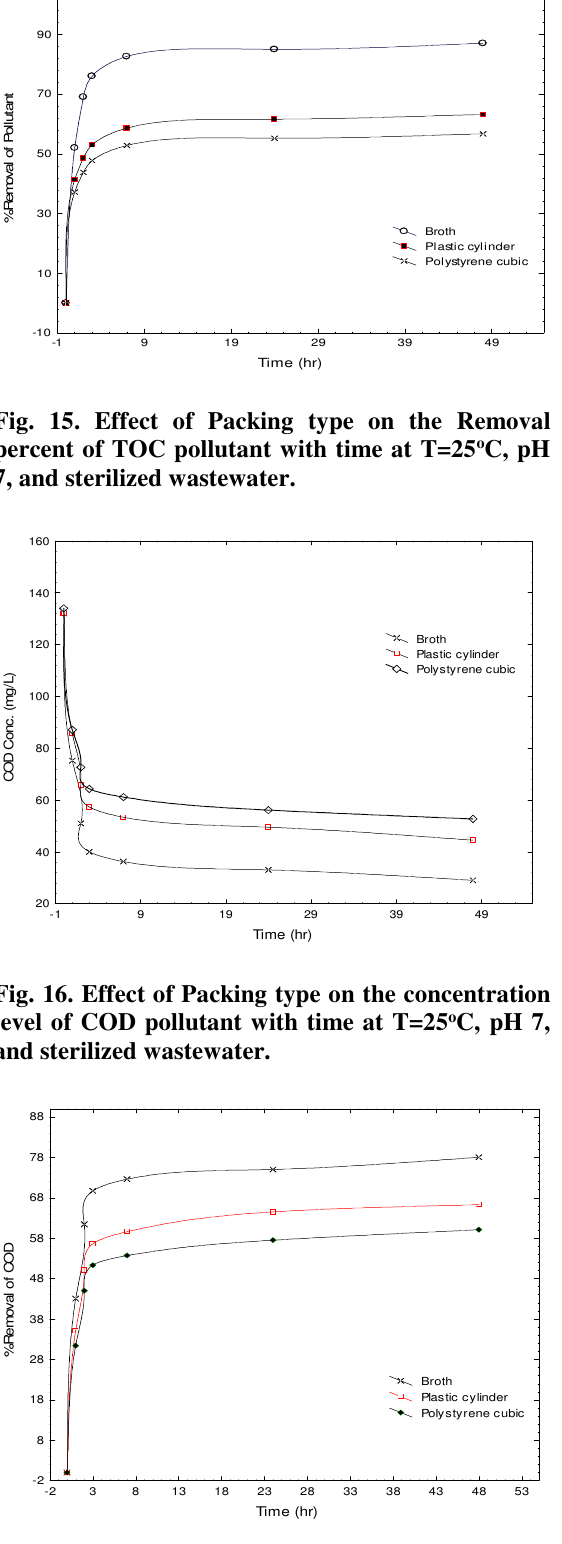
Fig. 17. Effect of Packing type on the Removal percent of COD pollutant with time at T=25 o C, pH7, and sterilized wastewater.